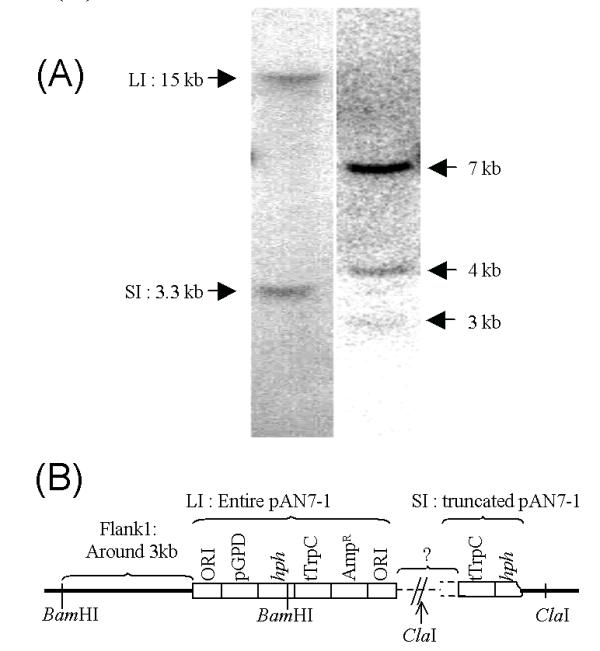
Analysis of pAN7-1 integration pattern in s2.(A) Southern blot analysis of total genomic DNA of s2 digested with ClaI, which does not cut the plasmid (lane 1), and BamHI, which cuts once in pAN7-1 (lane 2), and probed with the pAN7-1 vector. Sizes are indicated in kilobases (kb). (B) Restriction map of the pAN7-1 integration point in s2. Wild-type genomic DNA is shown as a thick line, pAN7-1 sequences are represented by the open bar, and the dotted line stands for unknown sequences. The fragment LI is inserted at the bacterial replication origin (ORI). SI is truncated and carries a part of hph and of tTrpC.